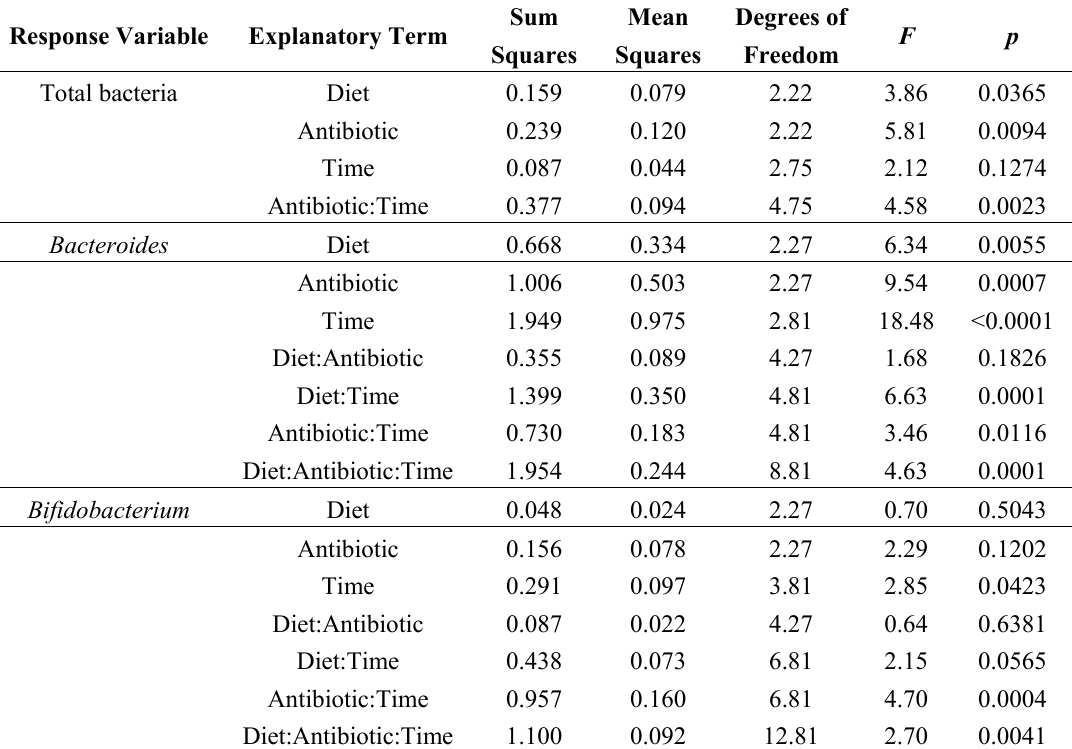
Table 1. Linear mixed effects model of bacterial cell counts over time. The best models included time as a quadratic term for total bacteria and Bacteroides , and time as a factor for Bifidobacterium